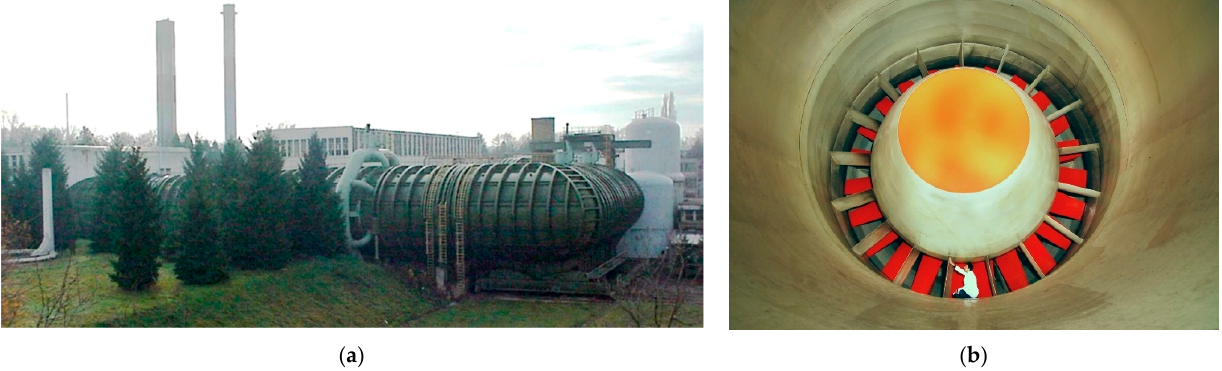
Figure 3. The T-35 subsonic wind tunnel of VTI: ( a ) external view; ( b ) the variable-pitch fan blades of T-35 [44].